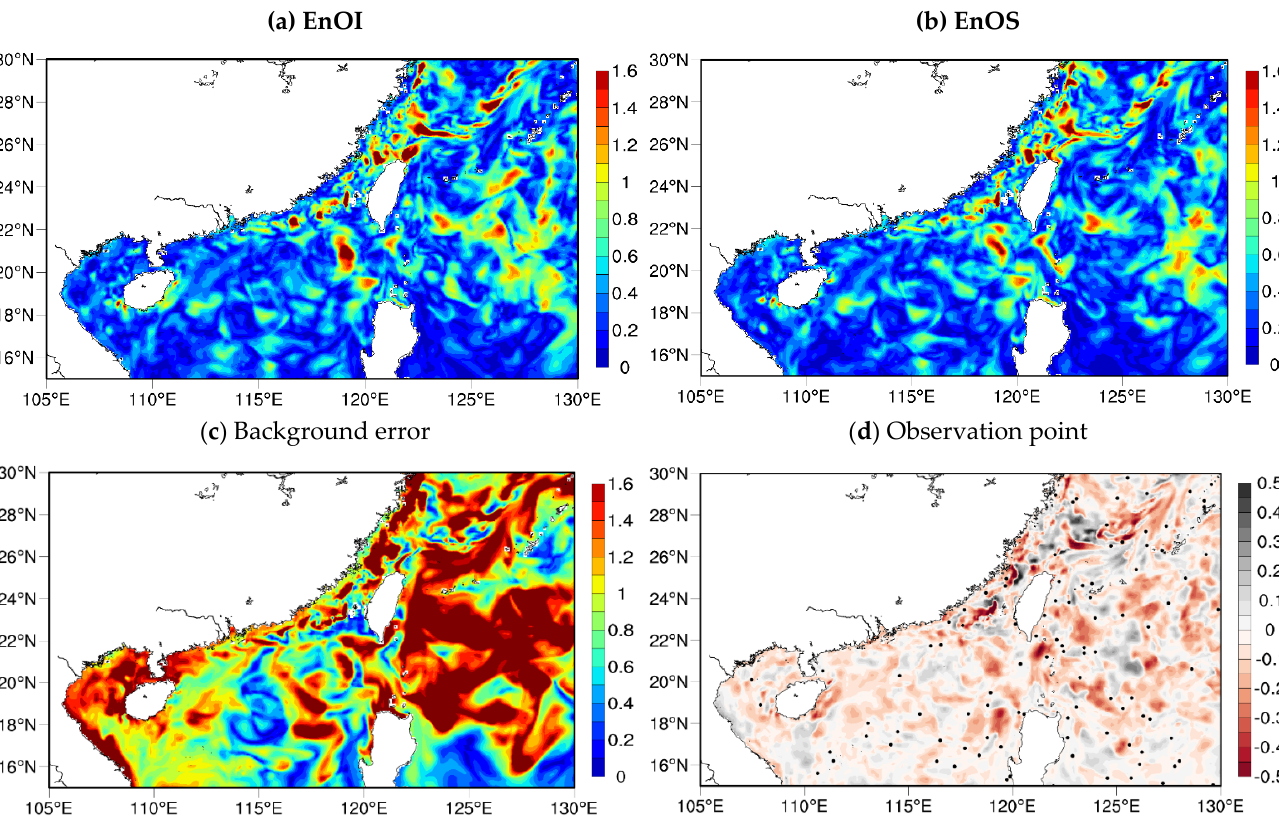
Figure 8. ( a ): RMSE distribution of the analysis and target fields of EnOI for 365 days in 2015; ( b ): RMSE distribution of the analysis and target fields of EnOS for 365 days in 2015; ( c ): RMSE distribution of the background and target fields for 365 days in 2015; ( d ): distribution of observations over the difference of RMSE of EnOI minus RMSE of EnOS, and the black dot in the figure is the observation point.